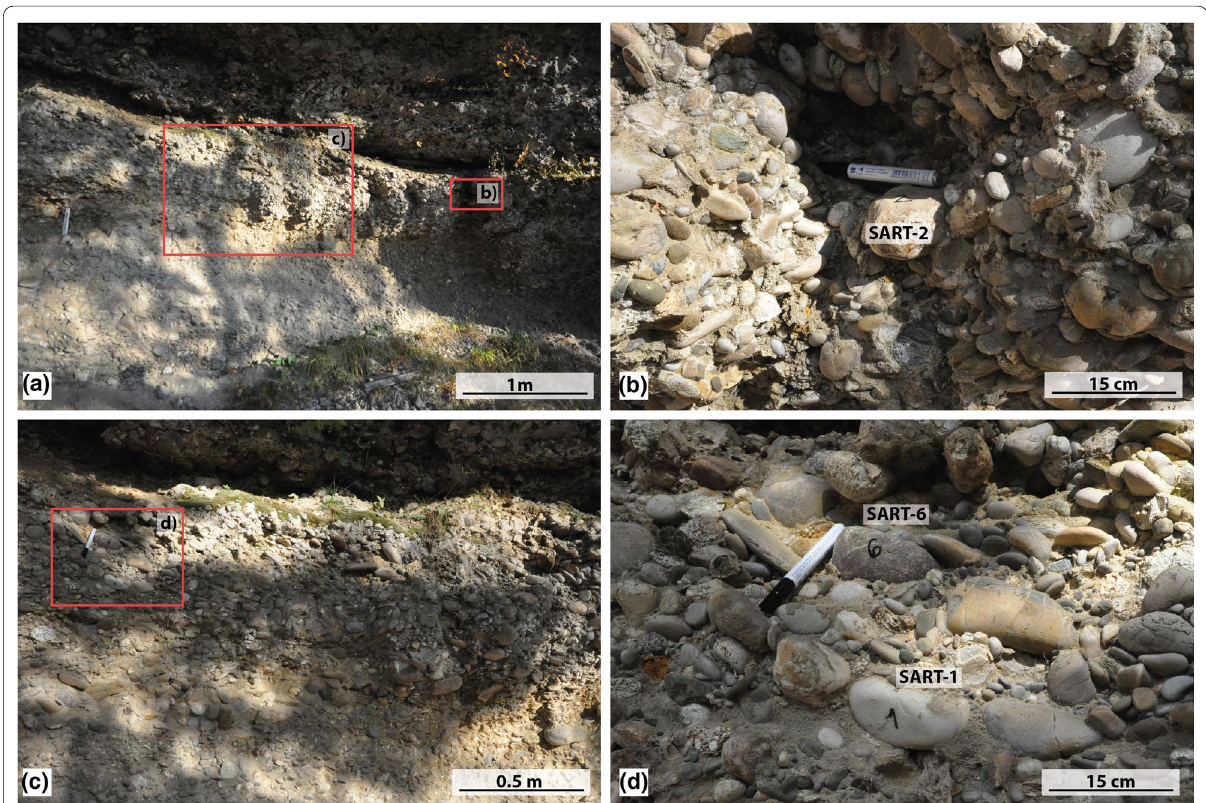
Fig. 4 Field photographs of the Schartenflue site. a Overview of the outcrop and positions of the close-up photographs b and c . b Photograph of the sample SART-2. c Close-up photograph of the Langacher Gravel and the position of close-up photograph d . d Photographs of the samples SART-6 and